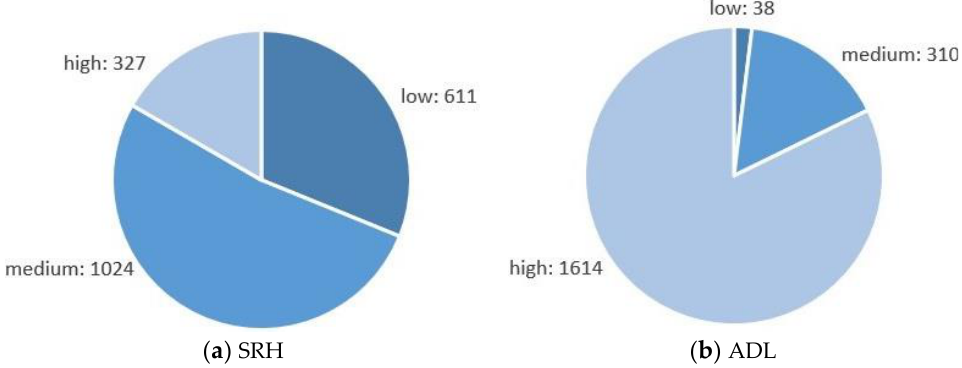
Figure 1. Health distribution of the No. 1 database samples.